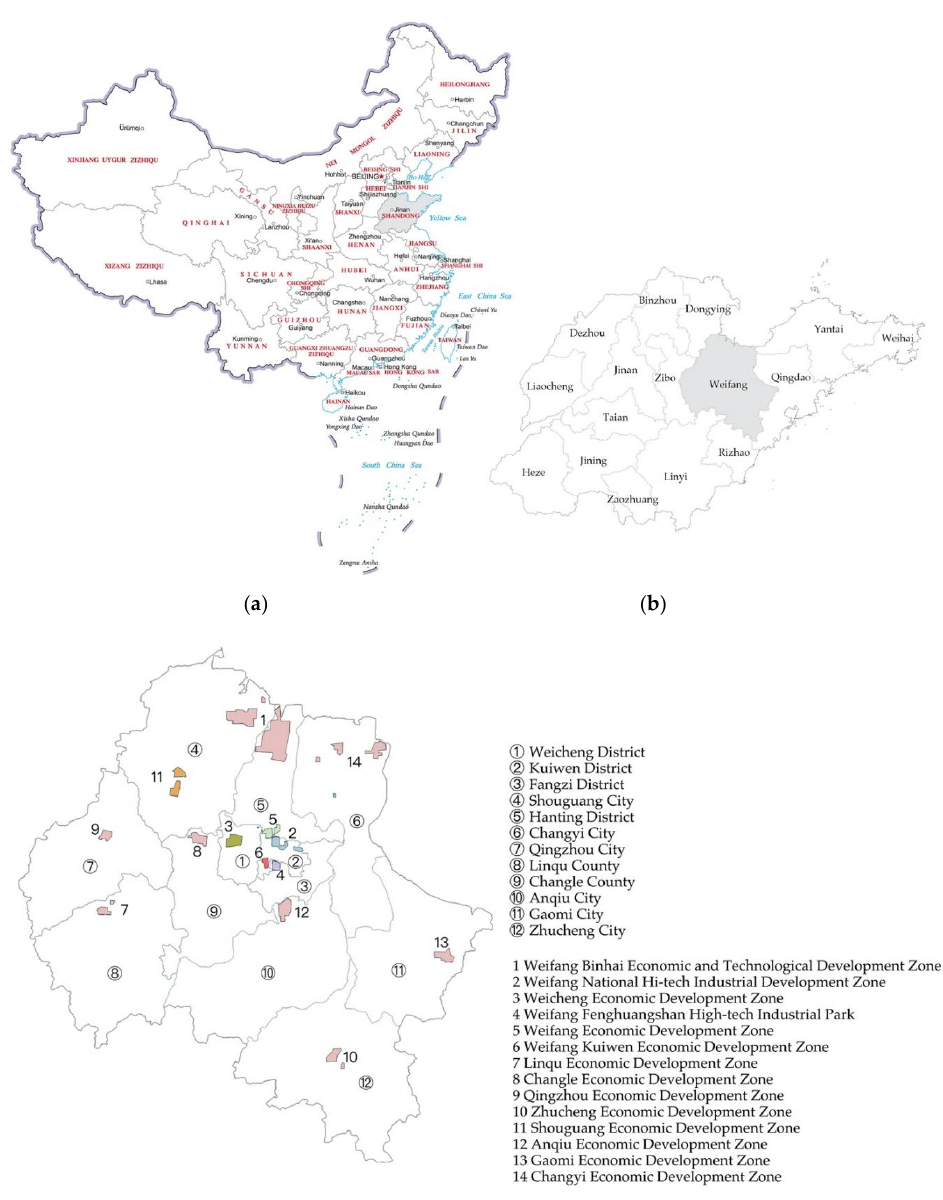
Figure 2. Study area with location of development zones: ( a ) the location of Shandong Province in China; ( b ) the location of Weifang in Shandong Province; ( c ) distribution of development zones in Weifang.